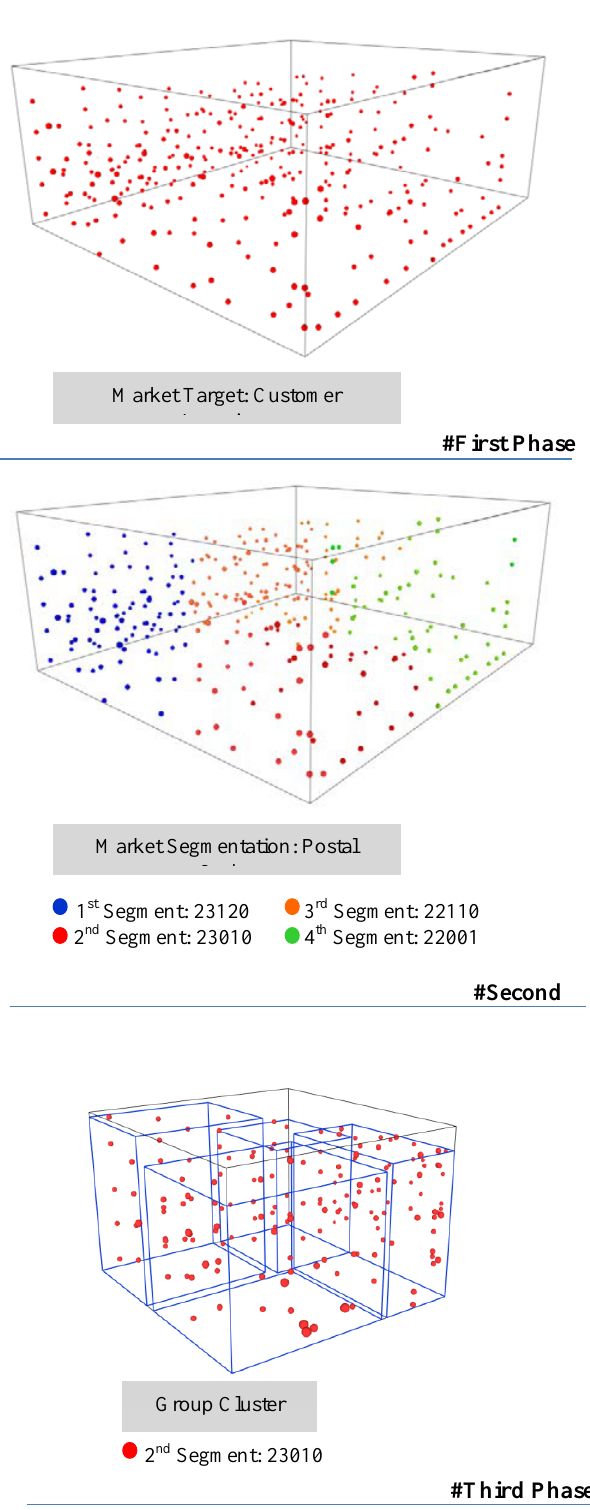
Figure 3. The workflow of market